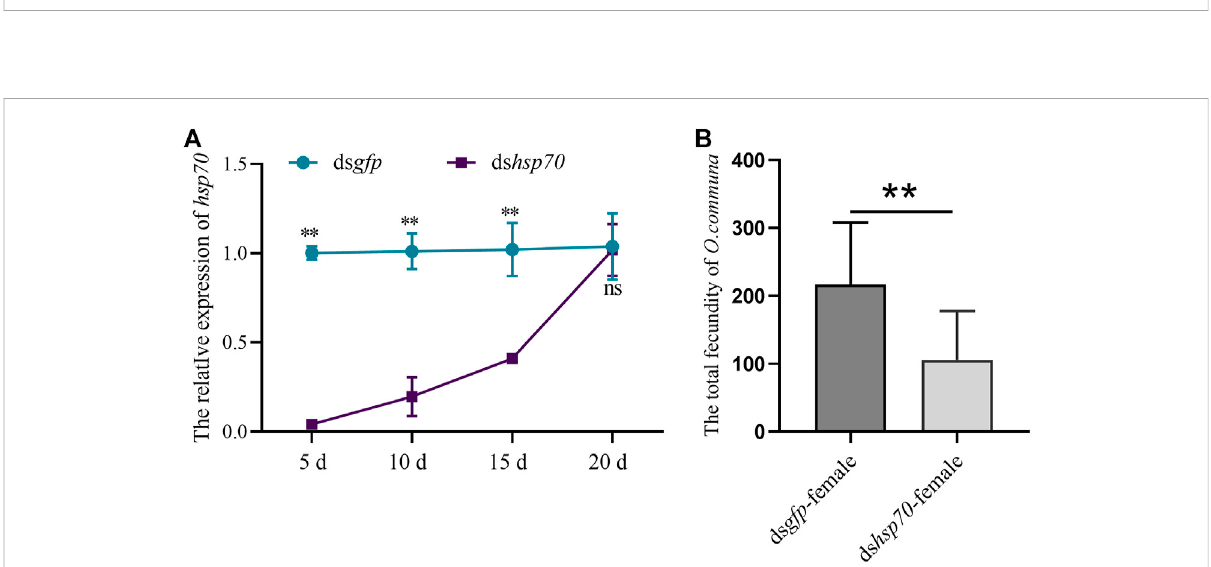
FIGURE 3 Functional characterization of Ochsp70 and evaluation of RNA silencing ef fi ciency in females. (A) Expression levels of Ochsp70 (5, 10, 15, and 20 d) after dsRNA was injected dsRNA was injected into the females. (B) Effect of Ochsp70 on female fecundity. Bars with the same letter are not signi fi cantly different from each other at p < 0.05 level, as per the LSD